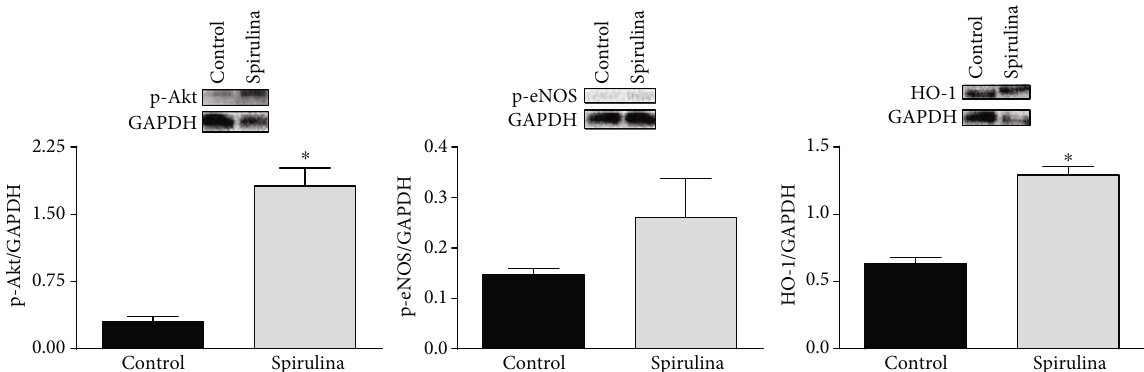
Figure 7: Representative western blot and densitometric analysis for the expression of p-Akt, p-eNOS, and HO-1 protein in aortic segments from SHR in the absence (control) or in the presence of the aqueous Spirulina extract. Results ( means ± SEM ) are expressed as the ratio between the signal for p-Akt, p-eNOS, or HO-1 protein and the signal for GAPDH. Number of animals: 3-5. ∗ p < 0 : 01 compared with the control condition (in the absence of Spirulina